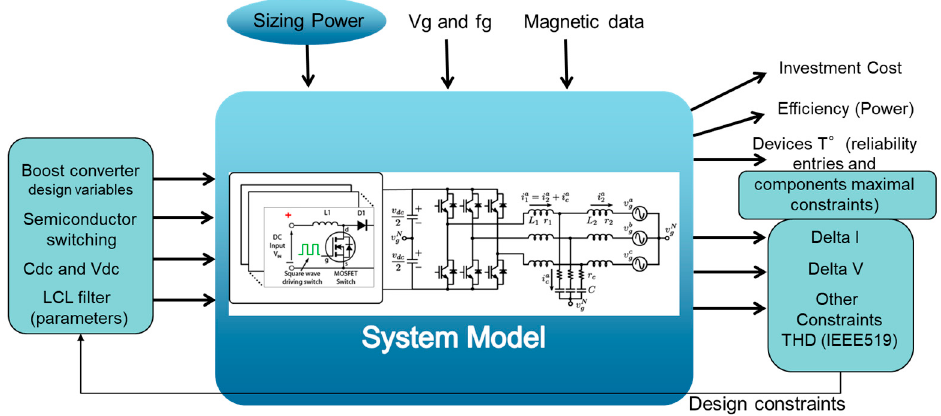
Figure 18. The design level of optimization procedure considering design variables as input.